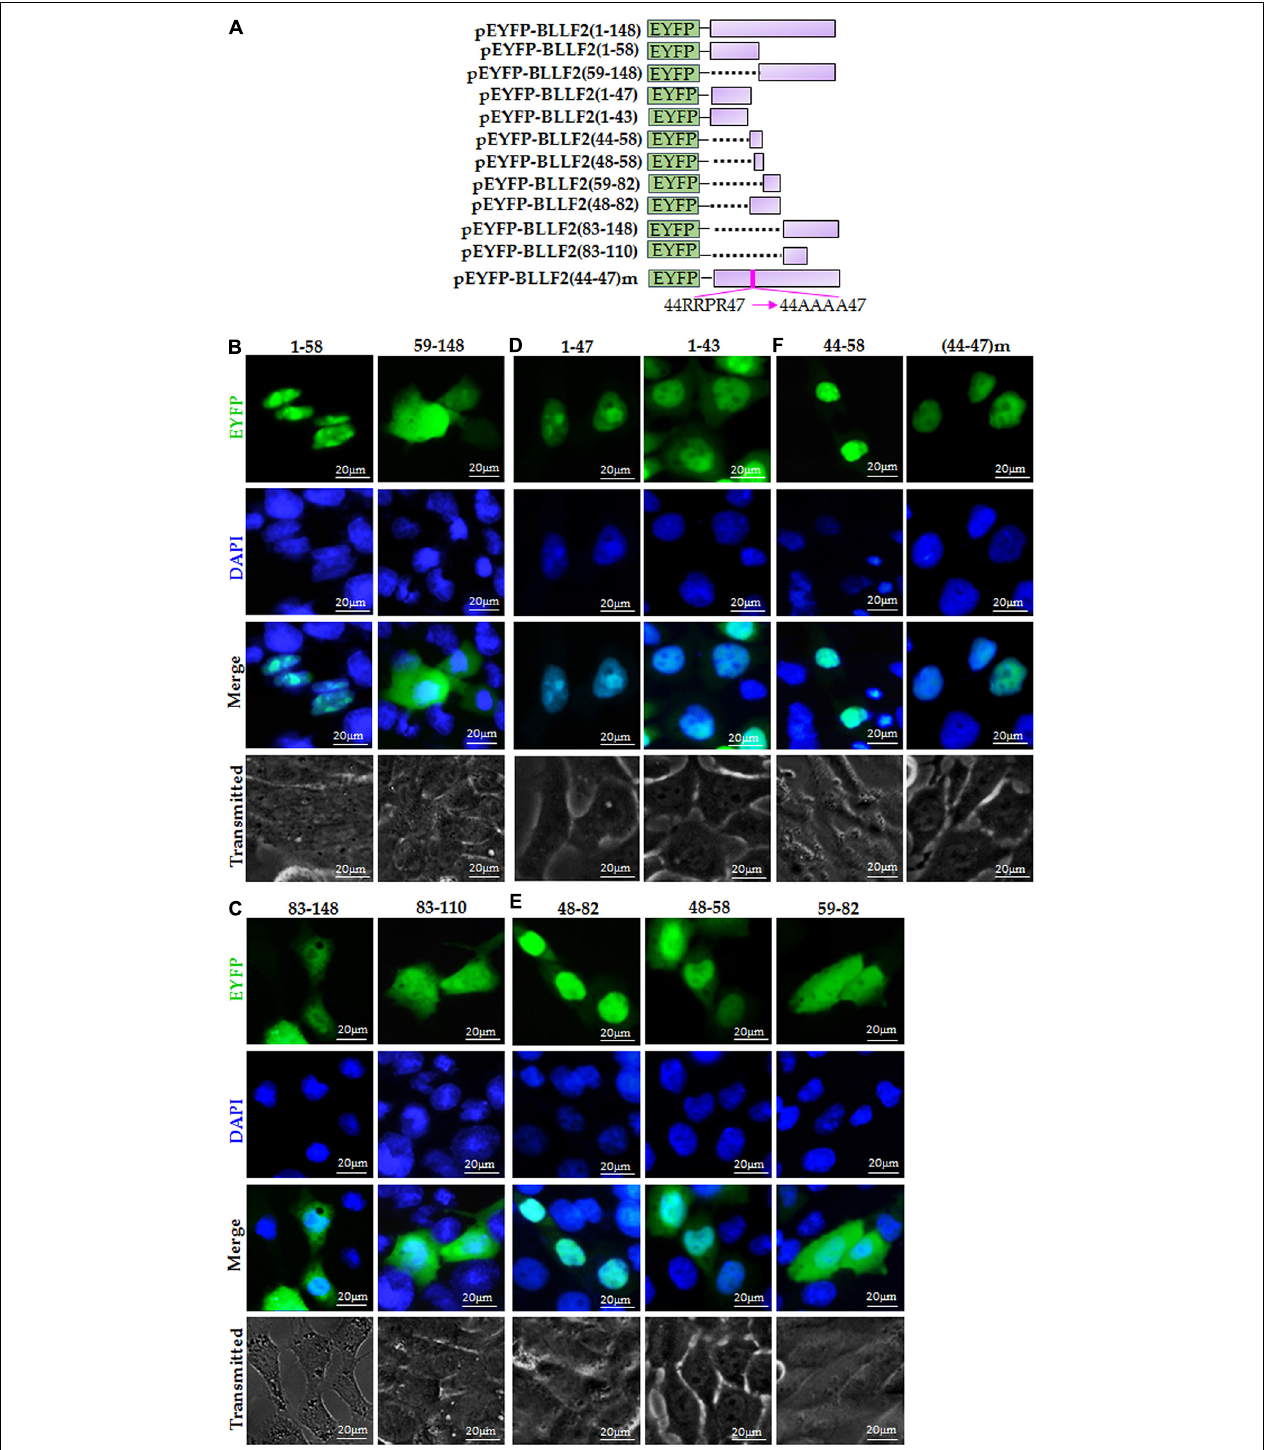
FIGURE 2 | Identification of the predicted NES and functional NLS in BLLF2. (A) Schematic diagram of constructs encoding EYFP-tagged wild-type BLLF2 and its deletion mutants aa1–43, 1–47, 1–58, 44–58, 48–58, 48–82, 59–82, 59–148, 83–148, 83–110, and full-length mutant BLLF2(44–47)m. (B) Intracellular localization of deletion mutants BLLF2(1–58) and BLLF2(59–148) in COS-7 cells. (C) Intracellular localization of deletion mutants BLLF2(83–143) and BLLF2(83–110) in COS-7 cells. (D) Intracellular localization of deletion mutants BLLF2(1–47) and BLLF2(1–43) in COS-7 cells. (E) Intracellular localization of deletion mutants BLLF2(48–82), BLLF2(48–58), and BLLF2(59–82) in COS-7 cells. (F) Intracellular localization of deletion mutant BLLF2(44–58) and full-length mutant BLLF2(44–47)m in COS-7 cells. All scale bars indicate 20 µ m.